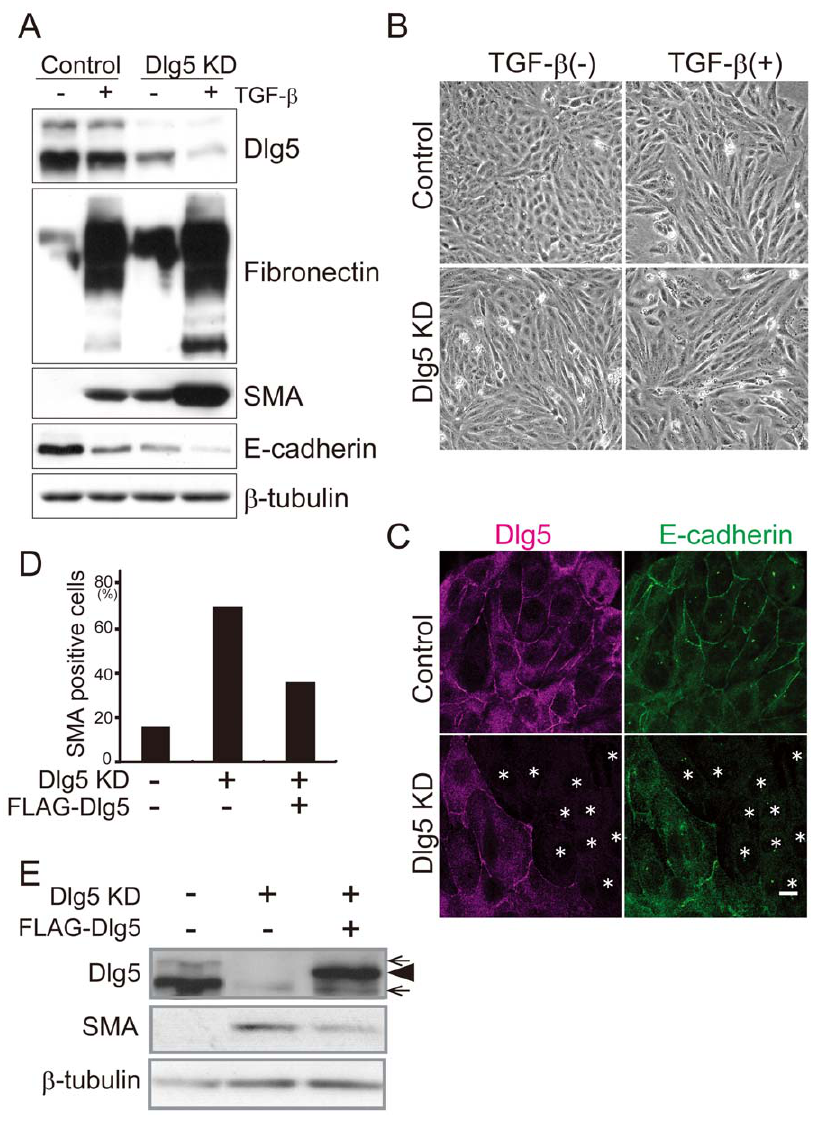
Figure 2. Dlg5 depletion disrupts epithelial cell morphology and induces the expression of mesenchymal marker proteins. A: LLc- PK1 cells were transfected with Dlg5 siRNA (siDlg5 # 1: KD) or control siRNA and then incubated with 4 ng/ml of TGF- b for three days. The cells were lysed and immunoblotted using the indicated antibodies. Expression of b -tubulin was examined as a loading control. The upper band observed in immunoblotting with anti-Dlg5 is the larger variant of Dlg5. B: Cells were treated as in A and incubated for 60 hours. The cells were then photographed using phase contrast microscopy to examine cell morphology. C: Cells were transfected with Dlg5 siRNA or control siRNA and then immunostained using anti-Dlg5 or anti-E-cadherin antibodies. The asterisks indicate the cells that were transfected with Dlg5 siRNA. The scale bar indicates 10 m m. D: LLc-PK1 cells were transfected with Dlg5 siRNA or control siRNA and incubated for 24 hours. A GFP expression plasmid was then transfected into the cells with FLAG-Dlg5 or control plasmids. After incubation for two days, the cells were immunostained using an anti-SMA antibody. Fifty GFP-expressing cells were randomly selected, and the fluorescent intensity of SMA staining was examined. The graph shows the ratio of cells with higher SMA expression than background. E: LLc-PK1 cells were transfected with FLAG-Dlg5 or control plasmid and incubated for six hours. The cells were further transfected with Dlg5 siRNA or control siRNA. After two days of incubation, the cells were lysed and immunoblotted using the indicated antibodies. Arrows indicate endogenously expressed Dlg5, and an arrow head indicates FLAG-Dlg5. Dlg5 depletion induced the expression of mesenchymal marker proteins, and the re-expression of Dlg5 suppressed it.